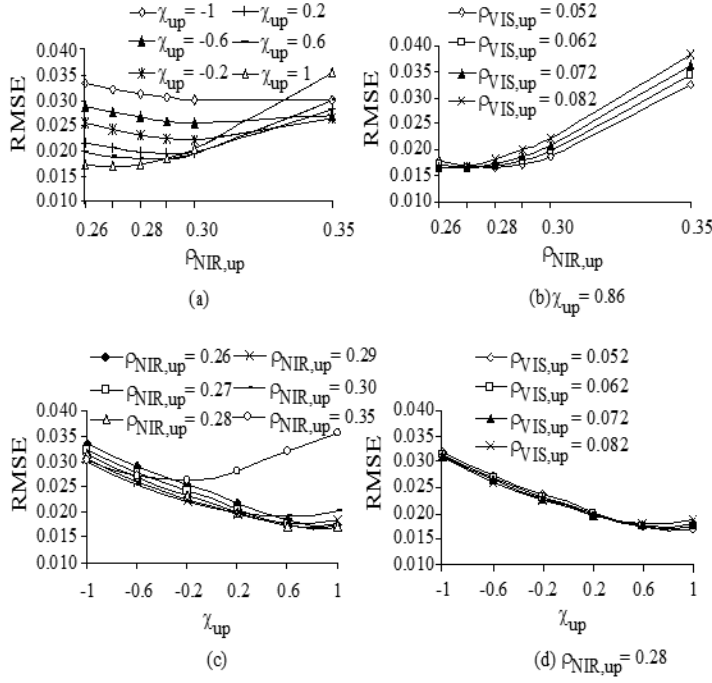
Fig. 6–RootMeanSquareError(RMSE)betweentheobservedandsimulatedalbedoasafunctionofthecanopyopticalparameters ρ χ up , for the Cuieiras Biological Reserve NIR , up and